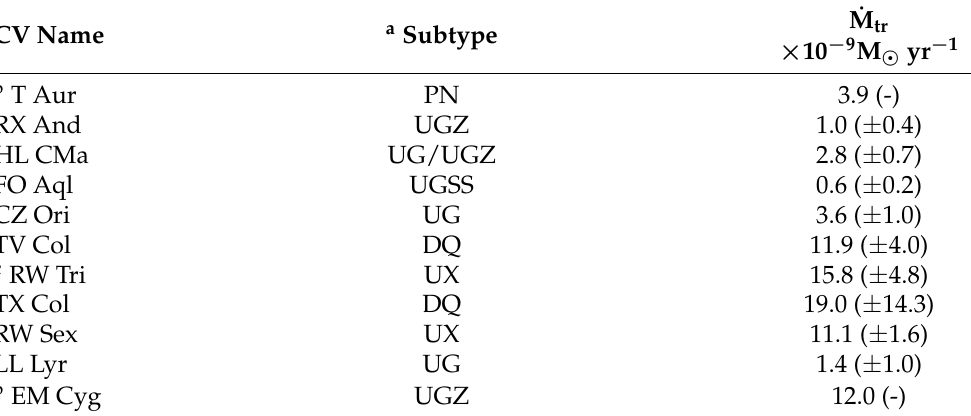
Table 3. Mass transfer rates of the CVs with the orbital periods similar to that of RW